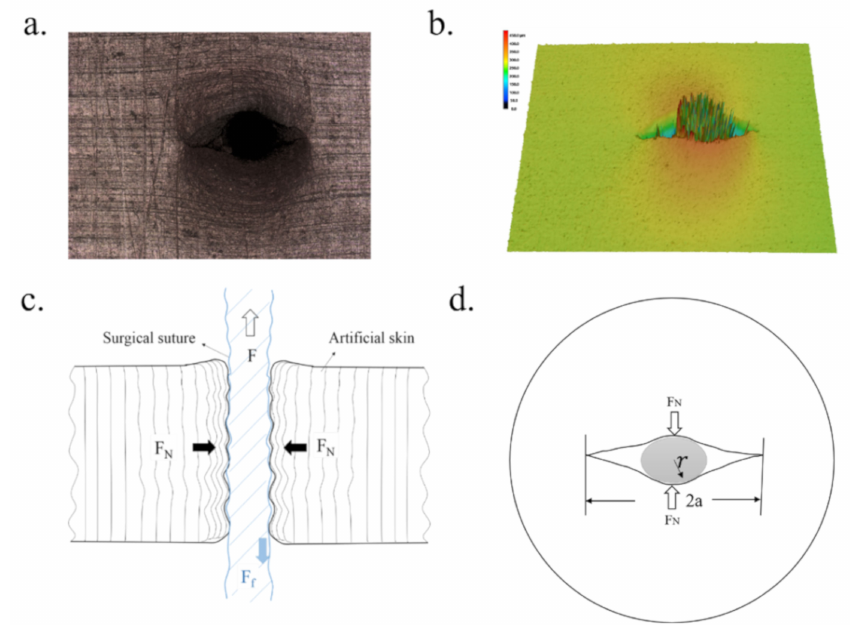
Figure 11. ( a ) Image of a surgical suture penetrating the skin substitute; ( b ) three-dimensional (3D) image of the surgical suture inserted into the skin substitute; ( c ) sketch of the surgical suture penetrating through the skin substitute; ( d ) force analysis of the surgical